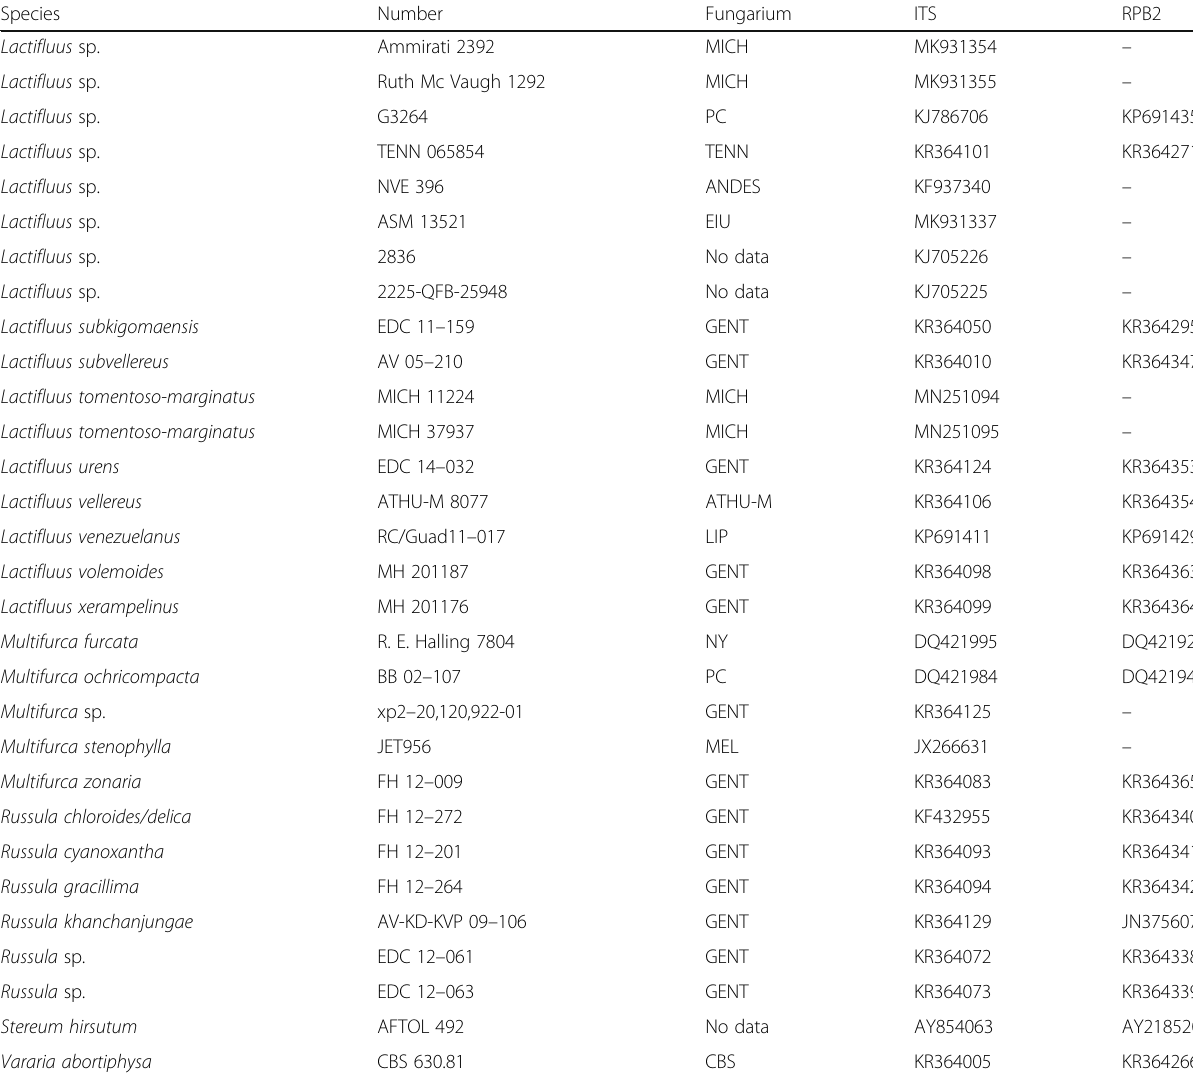
Table 1 Specimens and GenBank accession numbers of DNA sequences used in the molecular analyses (Continued)